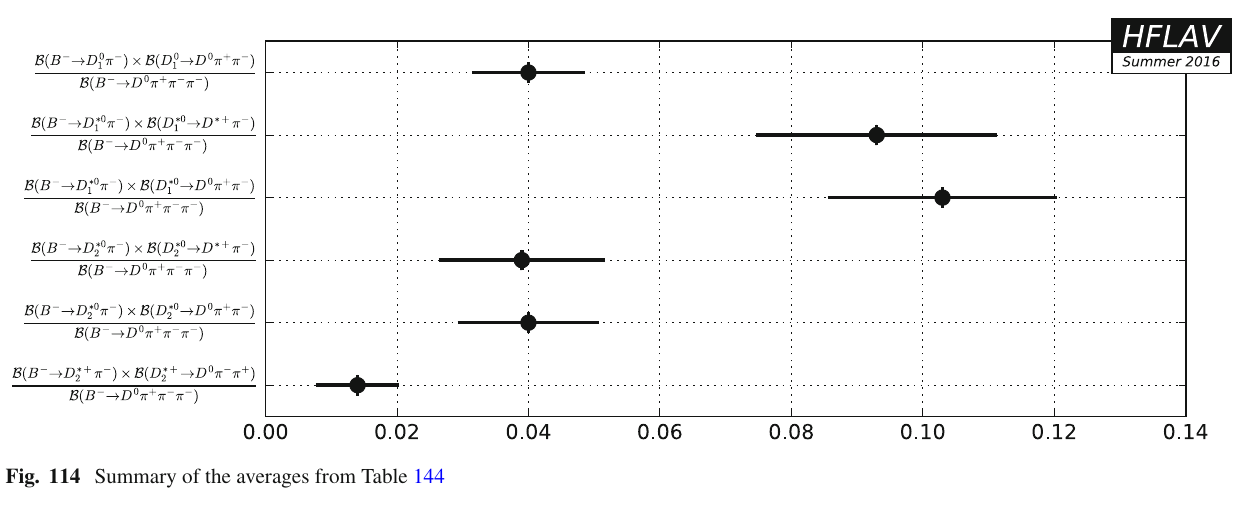
Fig. 113 Summary of the averages from Table 143